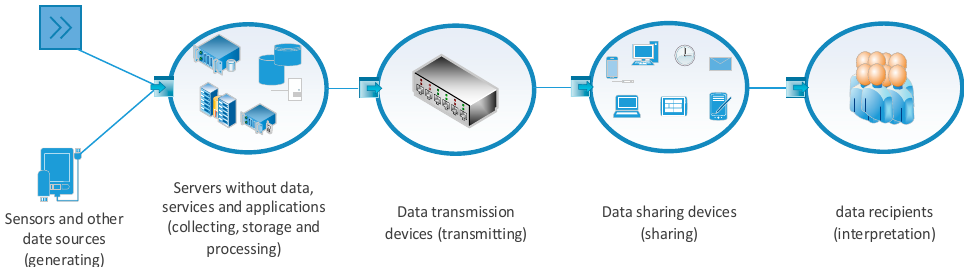
Figure 5. Diagram of a general information quality model of an information system [40].